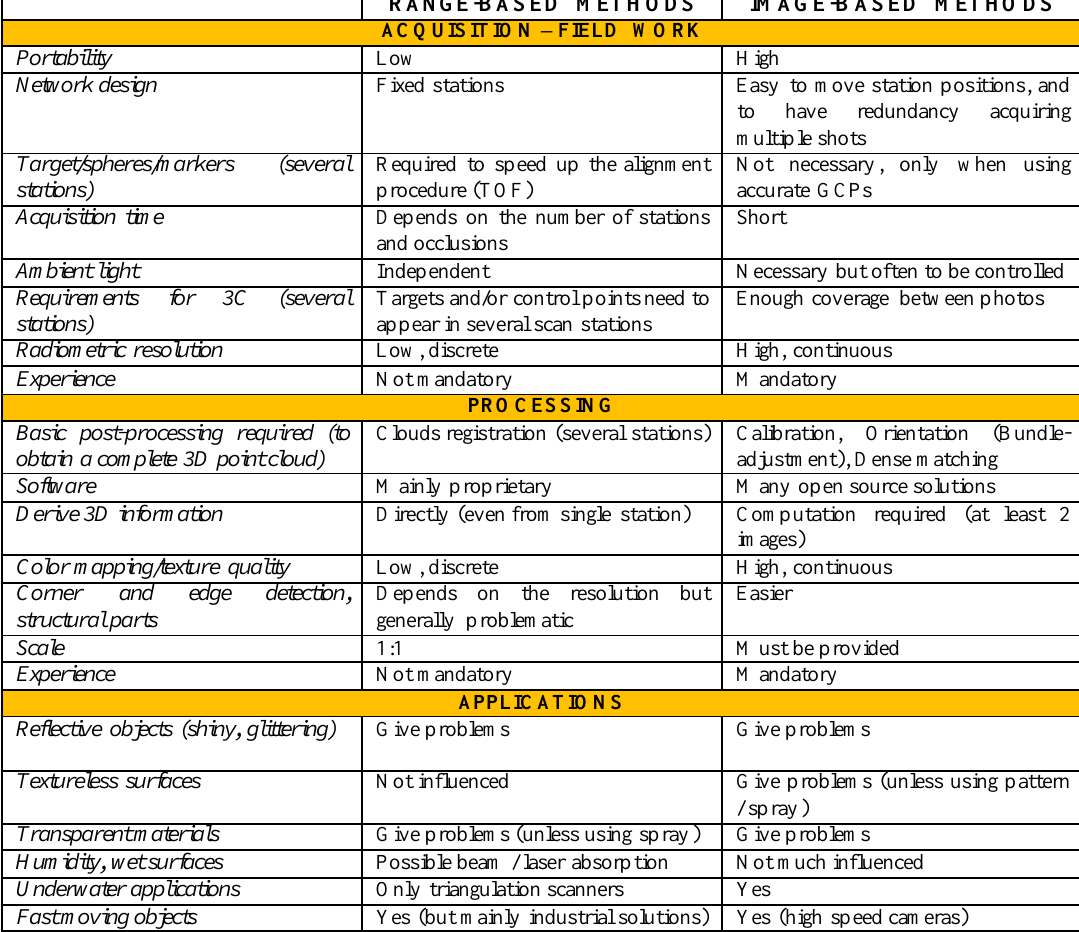
Table 1: Image-based and range-based approaches with the respective